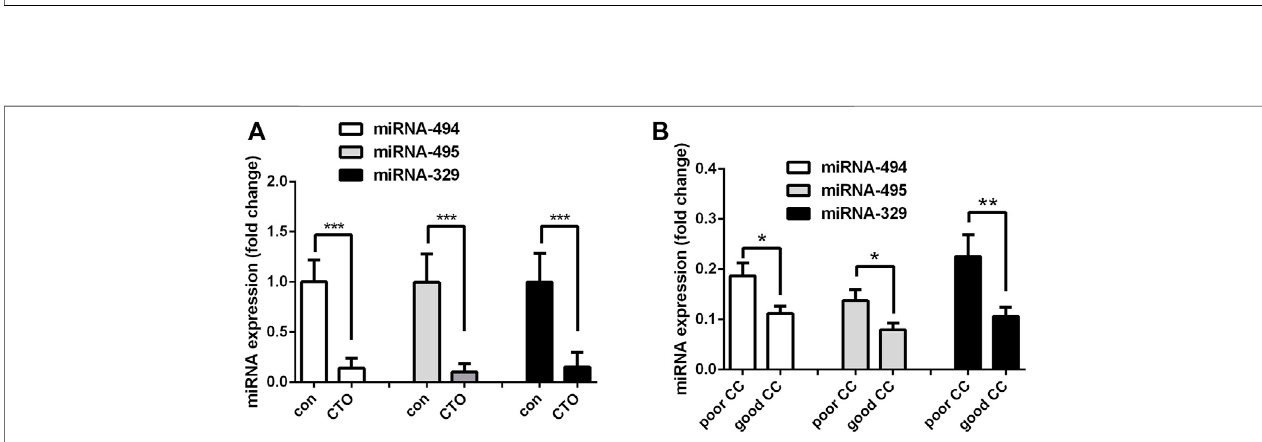
FIGURE 2 | GO and KEGG pathway analysis of DE lncRNA-miRNAs and miRNA-mRNA networks. (A) , the top 20 GO terms. (B) , the top 30 KEGG terms.